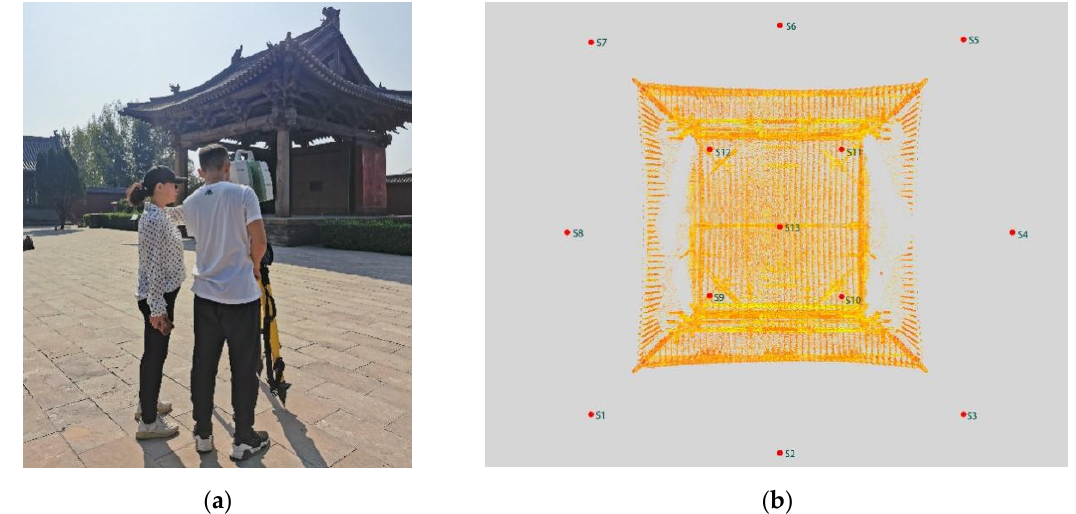
Figure 2. Terrestrial laser scanning. ( a ) Field work photo. ( b ) Site